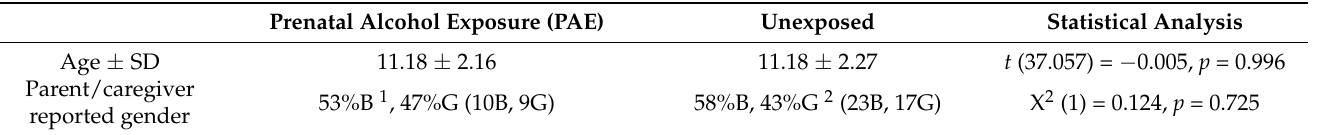
Table 1. Demographic